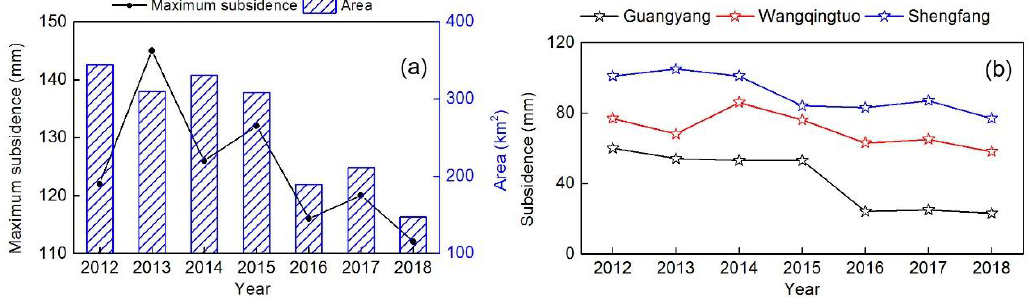
Figure 7. ( a ) The time-series subsidence change and area of subsidence greater than 50 mm from 2012 to 2018 in the typical Langfang and Tianjin region. ( b ) The annual land subsidence changes from 2012 to 2018 for three subsidence features.